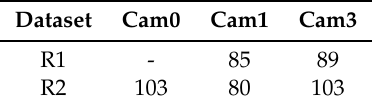
Table 2. Video pixel intensity threshold, I t , non-dimensional.